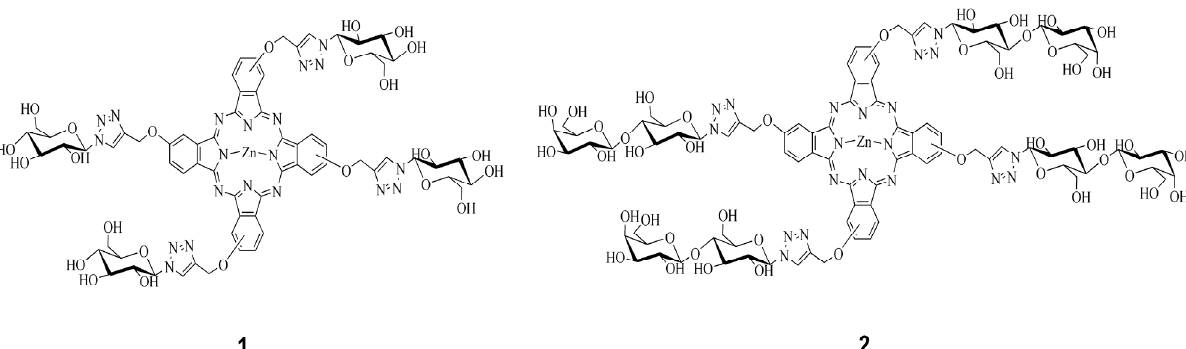
Figure 1. Structure of glucose-substituted zinc phthalocyanine ( 1 ) and lactose-substituted zinc phthalocyanine ( 2